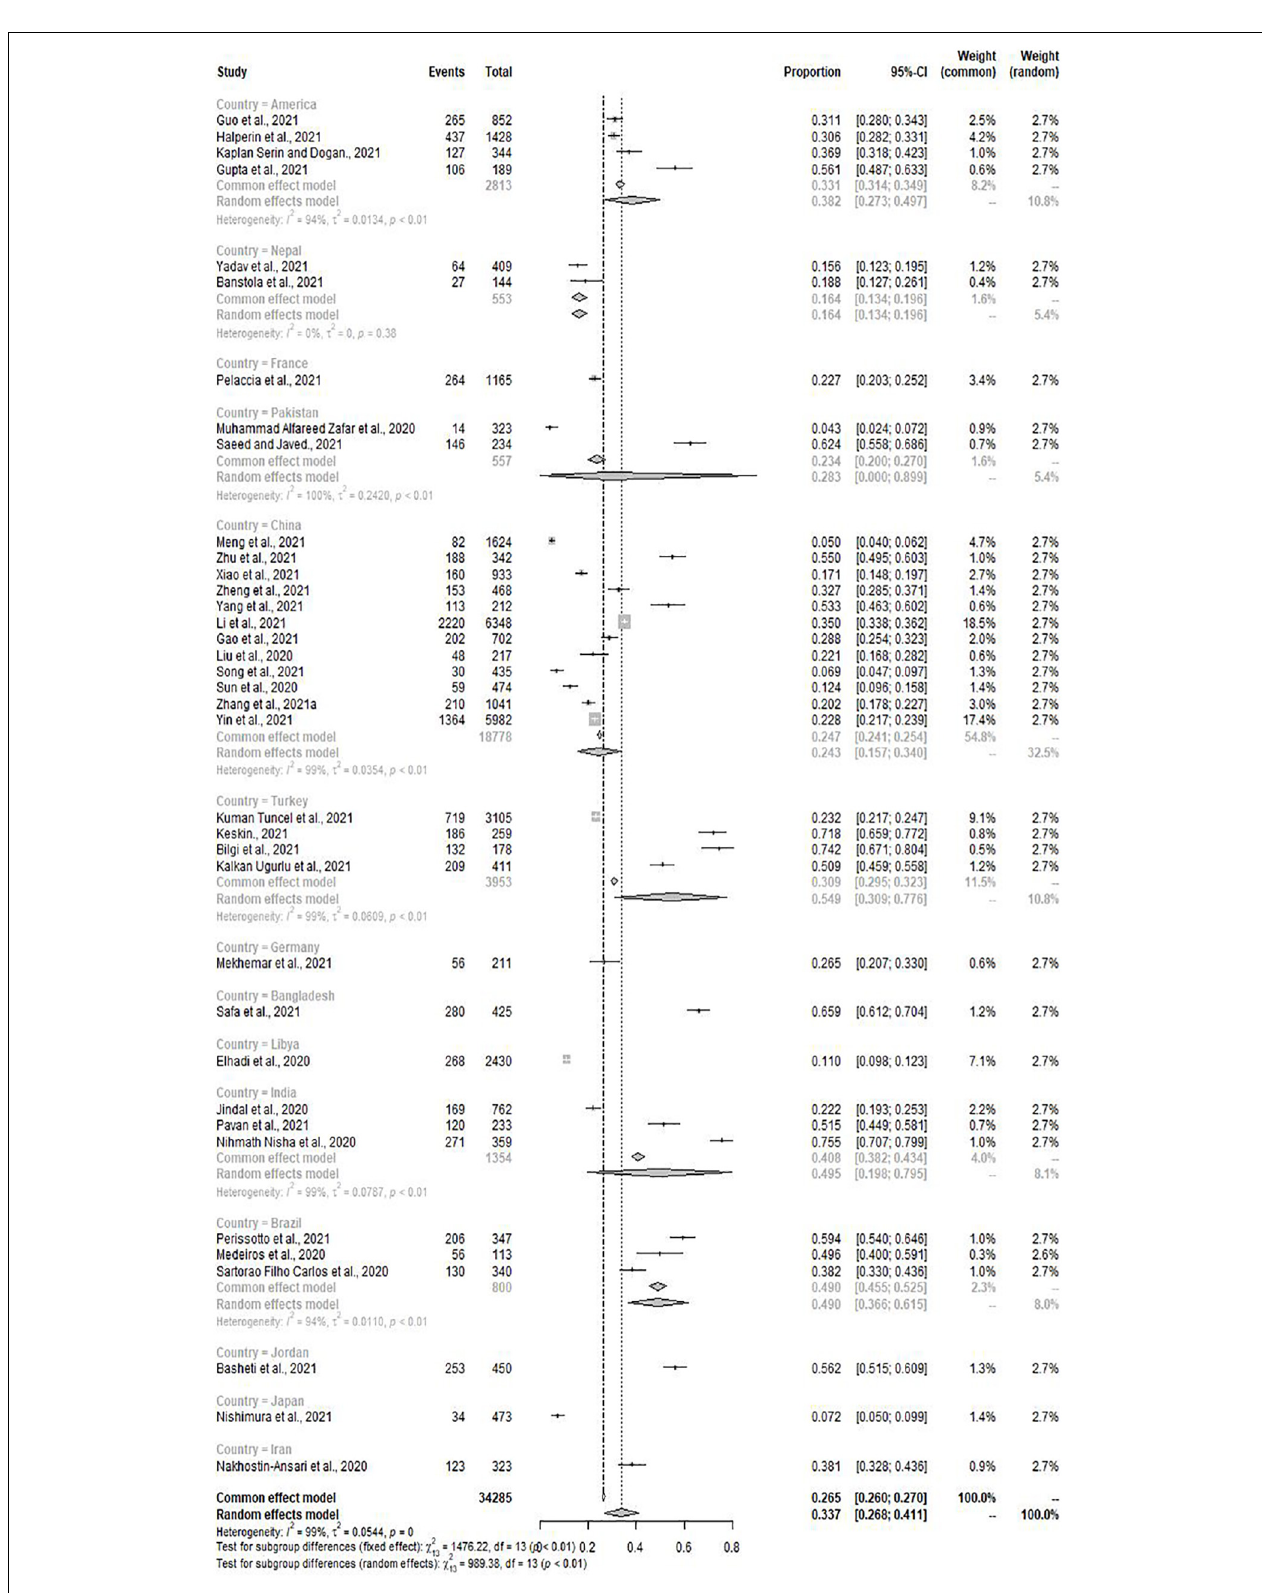
FIGURE 5 | Subgroup analysis by countries for